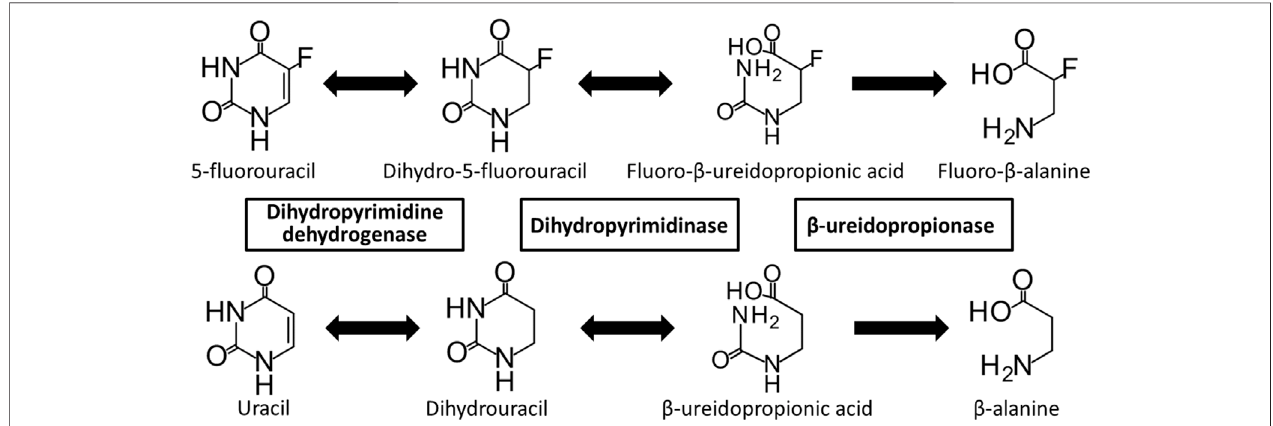
FIGURE 1 | Metabolic pathway of 5- fl uorouracil and uracil. 5-Fluorouracil and uracil are catabolized by dihydropyrimidine dehydrogenase, dihydropyrimidinase, and β -ureidopropionase.